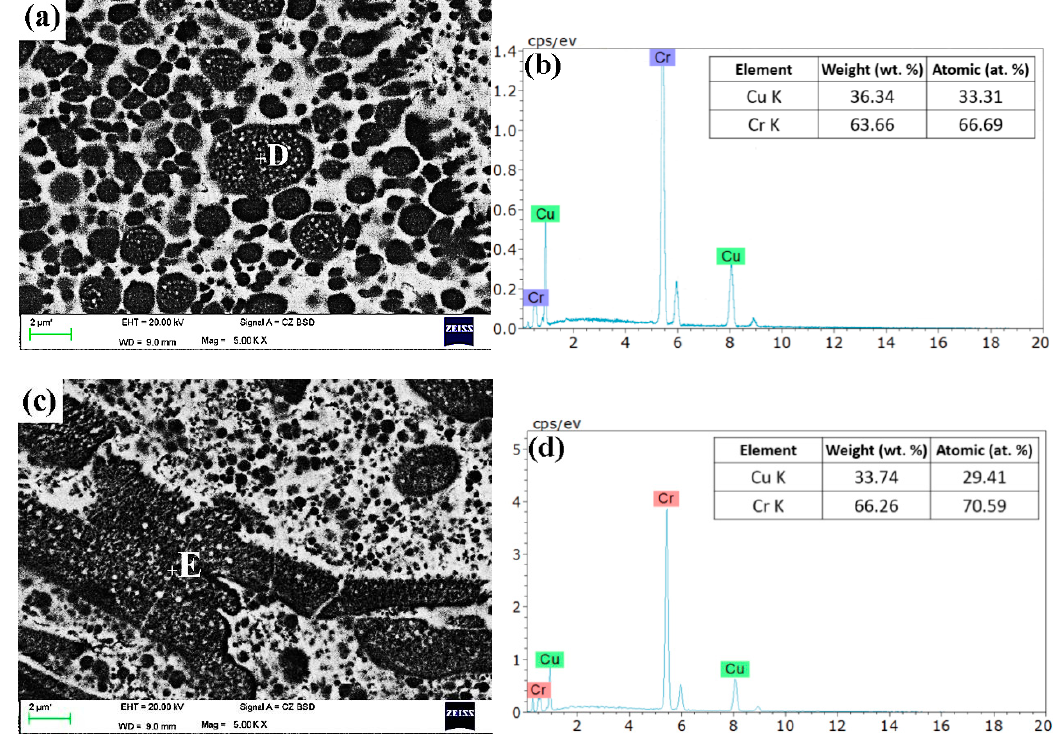
Figure 6. ( a ) Magnified image of the Cr-rich cluster in Figure 5c, ( b ) the corresponding EDS analysis of Point D, ( c ) magnified image Cr-rich sheet in Figure 5d, and ( d ) the corresponding EDS analysis of Point E.